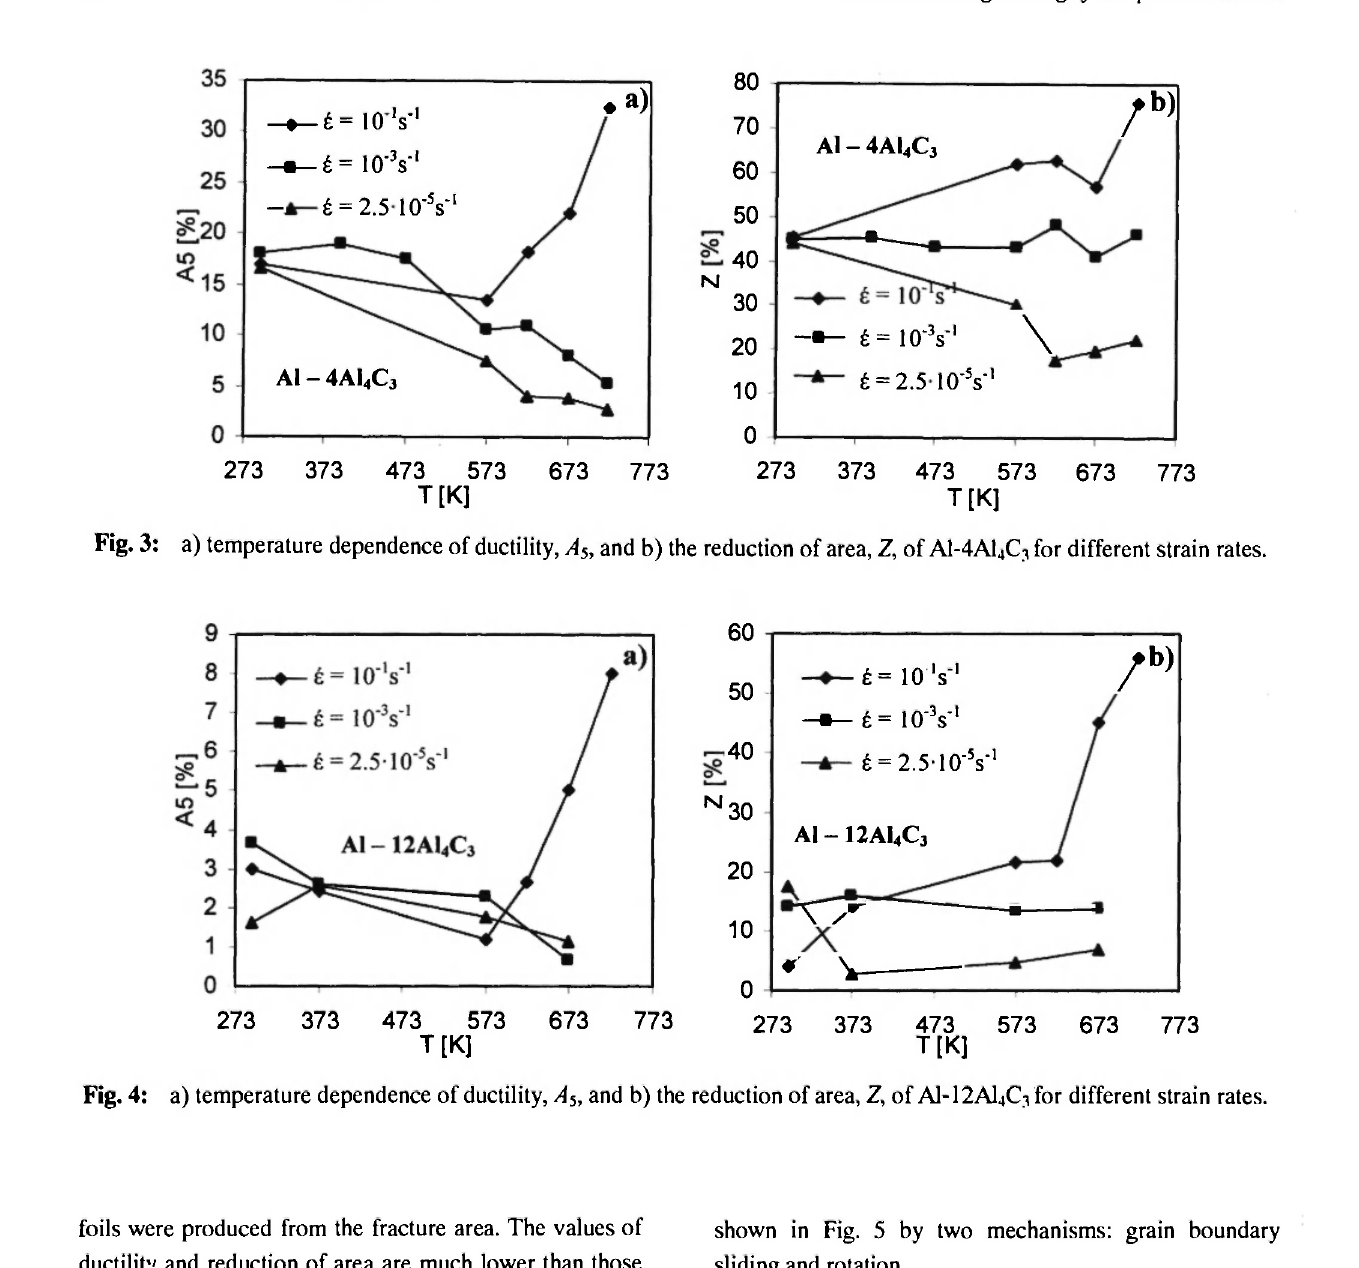
foils were produced from the fracture area. The values